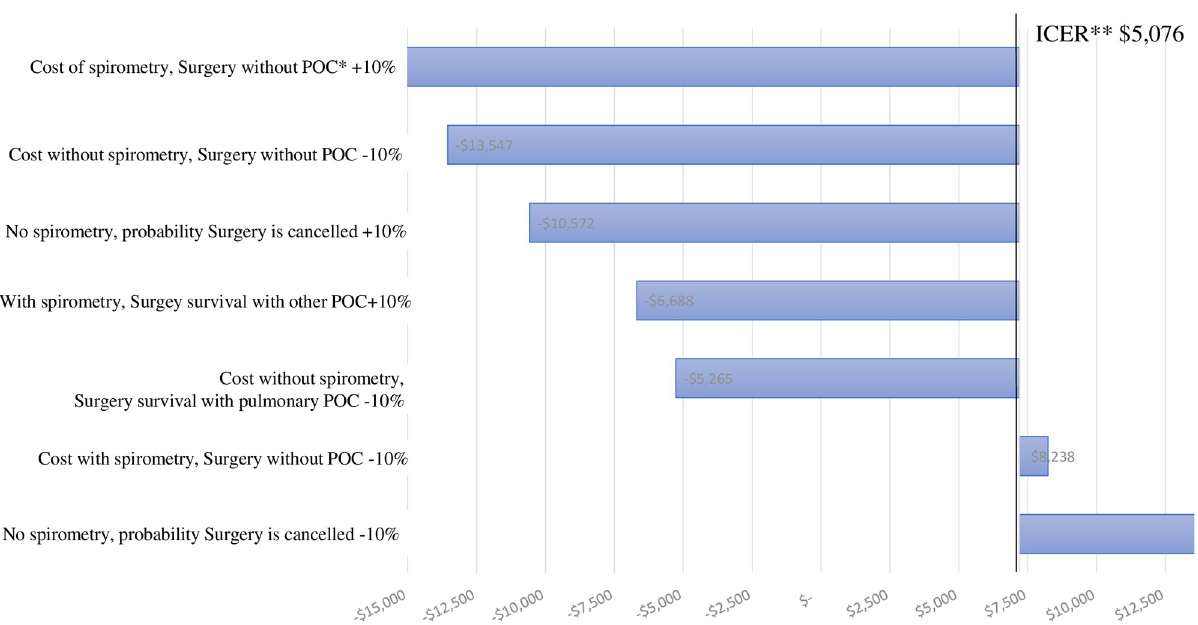
Fig 2. Sensitivity analysis of survival at moderate risk level. � POC, postoperative complications, �� ICER, incremental cost-effectiveness ratio.